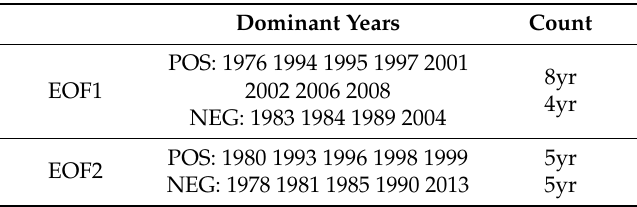
Table 1. Dominant positive and negative years of EOF